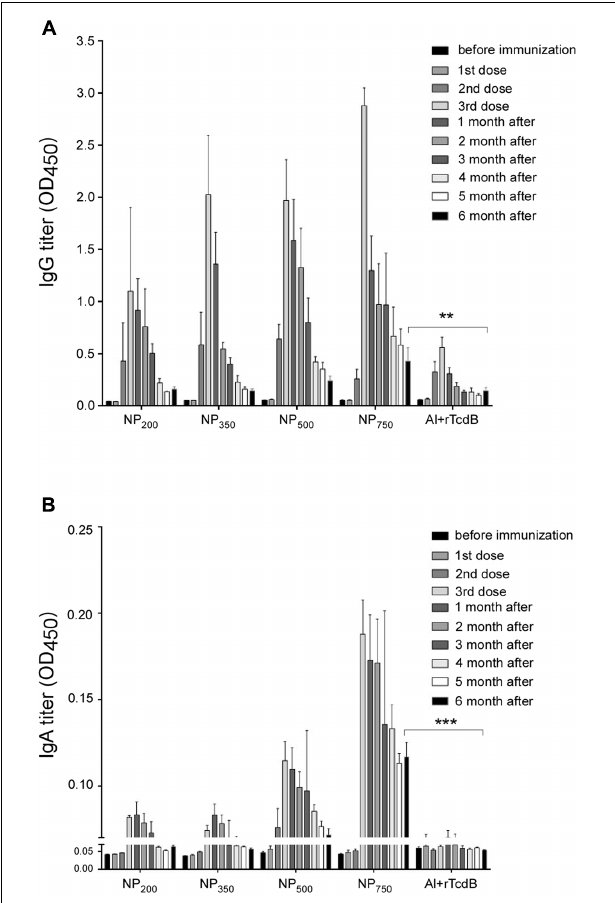
FIGURE 5 | Long-term antibody response of immunized mice. rTcdB-specific IgG (1:20,000 dilution) (A) and IgA (1: 1,000 dilution) (B) titers from the serum of immunized mice were determined by ELISA. NP 200 , NP 350 , NP 500 , NP 750 : injection with NP-rTcdBs with the corresponding size in nanometers; Al+rTcdB: injection with 20 µ g purified rTcdB mixed with Alum. All data are presented as mean ± standard deviations and statistical comparisons among groups were analyzed by Student’s t -test and ANOVA ( n = 5, ∗∗ P ≤ 0.01, ∗∗∗ p ≤ 0.001, ∗∗∗∗ p ≤ 0.0001). NS, not significant. All data are representative of at least three independent